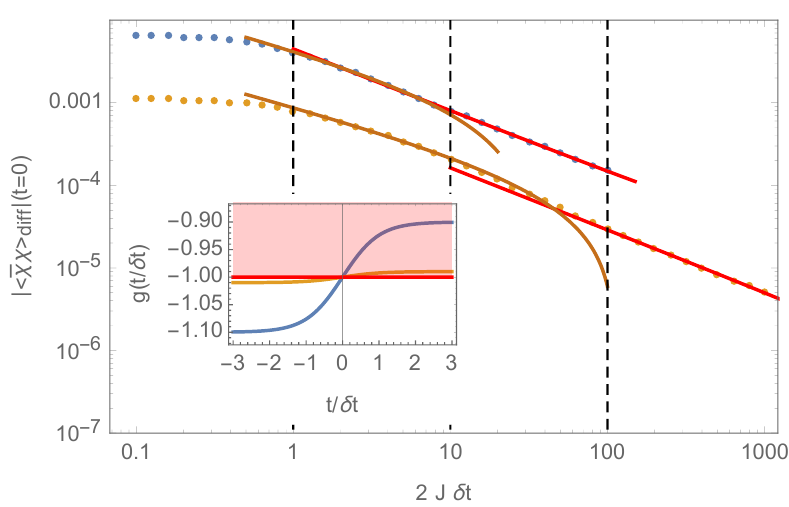
Figure 4 . Plot of h (cid:22) (cid:31)(cid:31) i di(cid:11) ( t = 0) as a function of 2 J(cid:14)t for the gapped-to-edge quench shown in the inset with g ( t ) = (cid:0) 1+ b tanh t=(cid:14)t , with b = 0 : 1 (blue), 0 : 01 (yellow). The red curves are the best (cid:12)t for the slow regime by a function P + Q (2 J(cid:14)t ) (cid:0) 3 = 4 , where P = (cid:0) 0 : 00448(blue), (cid:0) 0 : 000917 (yellow) and Q = (cid:0) 6 : 97 (cid:2) 10 (cid:0) 6 (blue), 1 : 617 (cid:2) 10 (cid:0) 7 (yellow). In the fast regime the brown curves indicate the best (cid:12)t of a function P + Q (2 J(cid:14)t ) (cid:0) 1 = 2 , with P = (cid:0) 0 : 00499(blue), (cid:0) 9 : 56 (cid:2) 10 (cid:0) 4 (yellow) and Q = 0 : 000860(blue), 8 : 96 (cid:2) 10 (cid:0) 5